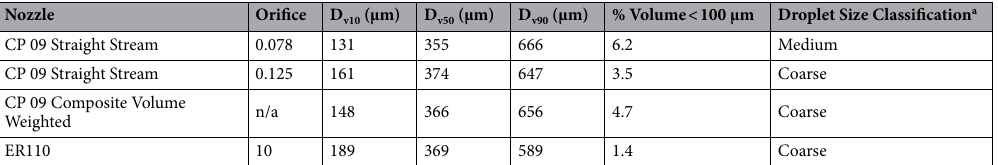
Table 3. Spray droplet size summary data from ground and aerial nozzles used in field spray drift experiment. a As established by Spray Nozzle Classification by Droplet Spectra , ASABE S572.3 (St. Joseph, MI: American Society of Agricultural and Biological Engineers, 2020) and data from laboratory wind tunnel generated reference nozzle